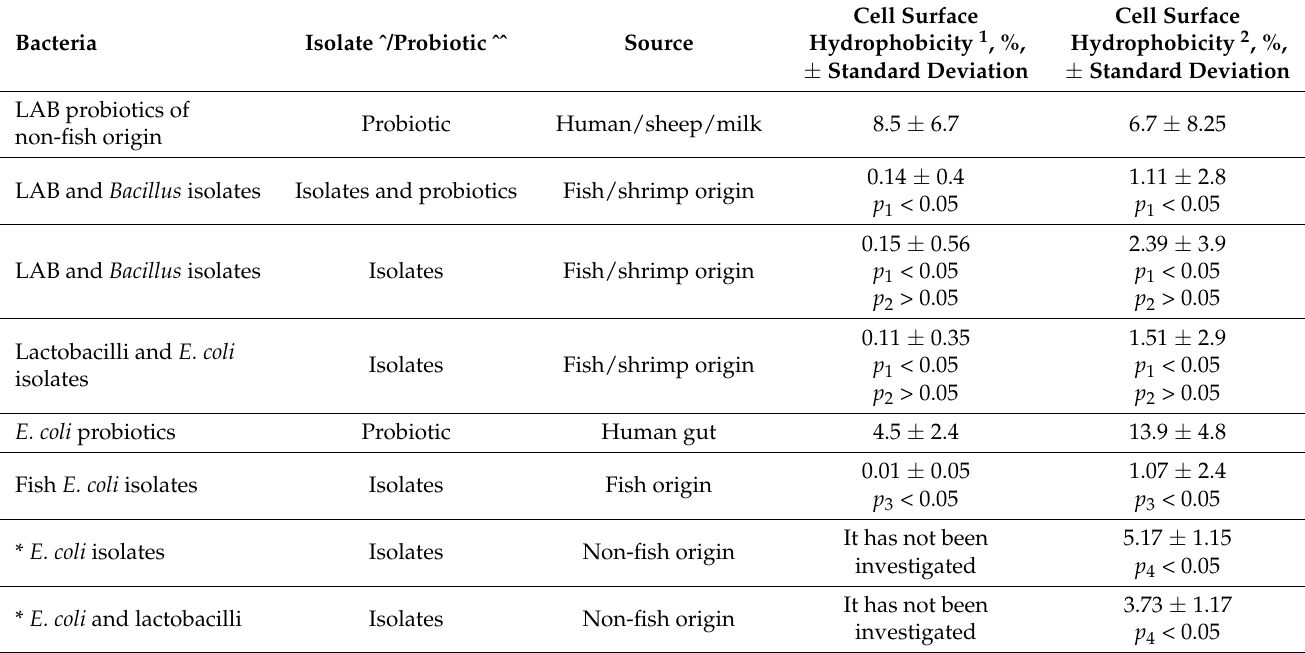
Table 1. Comparative characteristics of cell surface hydrophobicity of lactic acid bacteria and E. coli isolated from the fish gut